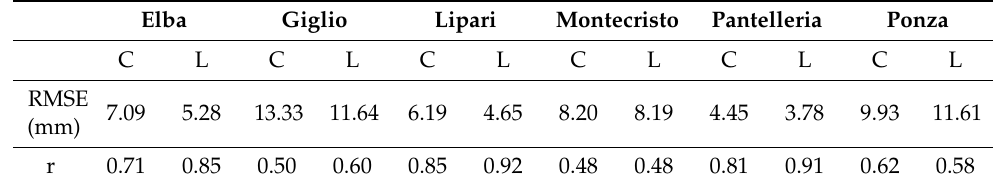
Table 4. RMSE and Pearson correlation coefficients for six islands in the Central Mediterranean basin around Italy. The statistics are computed considering the daily rainfall forecasts. The daily rainfall forecast is the summation of the eight 3 h forecasts within a day. Elba Giglio Lipari Montecristo Pantelleria Ponza